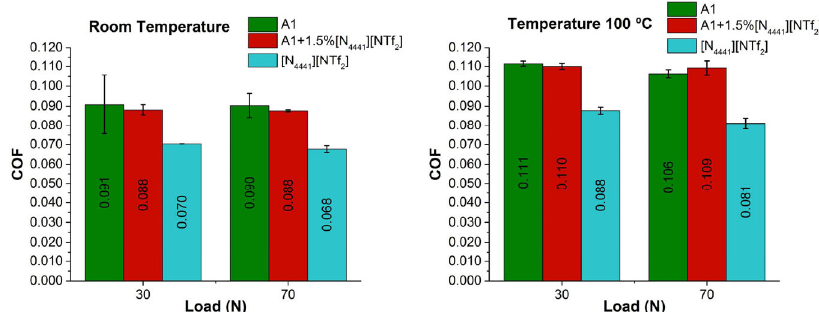
Fig. 3 Friction coefficient from tribological tests made at RT and 100 ° C.